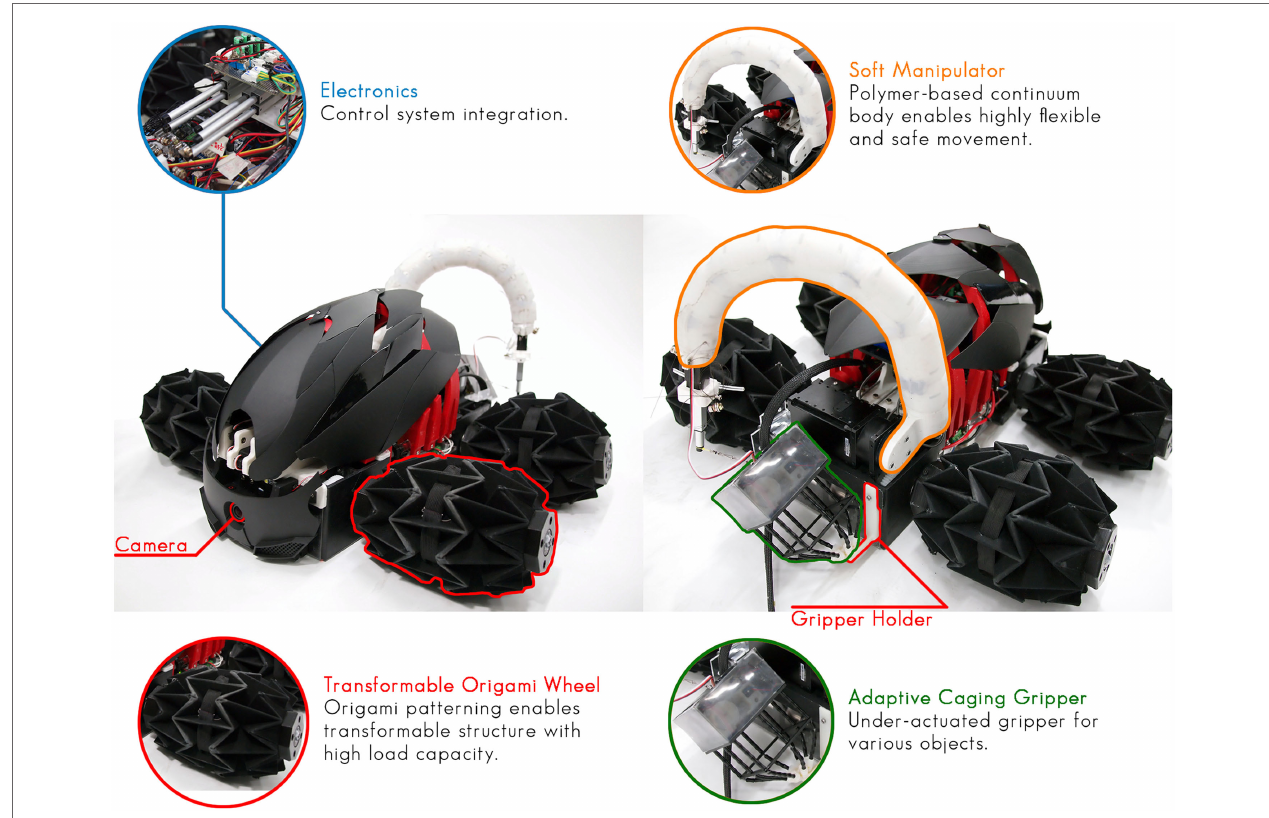
FigUre 2 | Overall view of snUMaX and description of key components